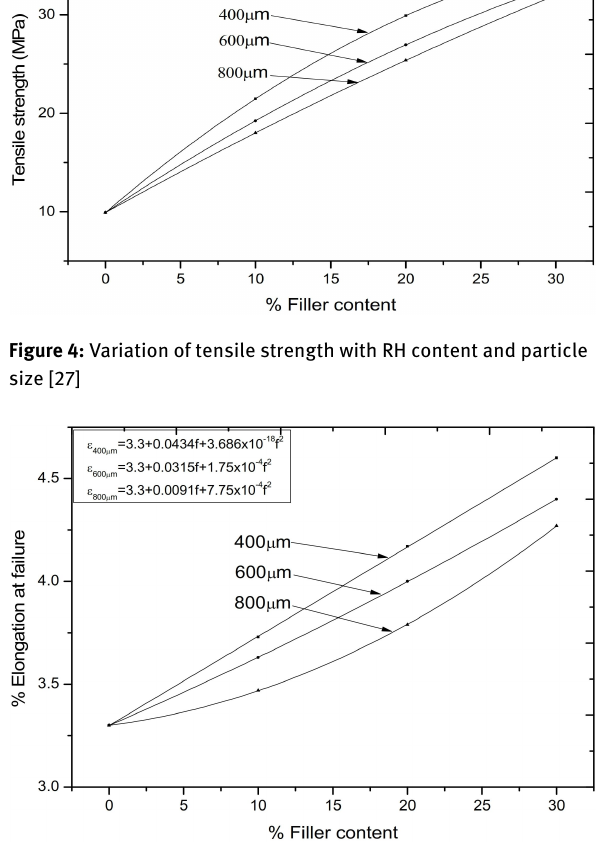
Figure 5: Variation of elongation at break with RH content and parti- cle size [27]